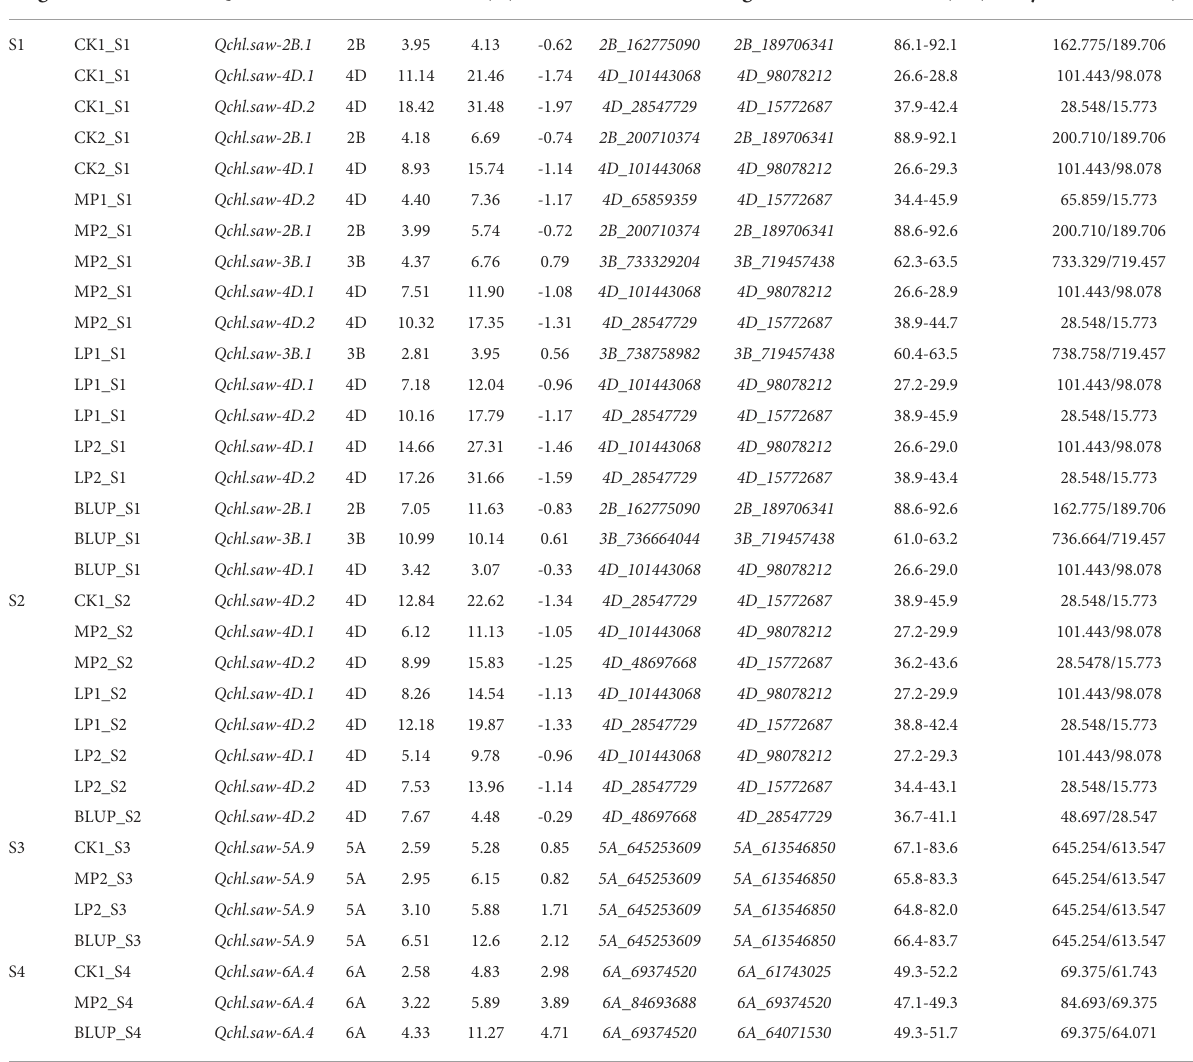
TABLE 4 Major QTLs for chlorophyll content at four stages under three phosphorus